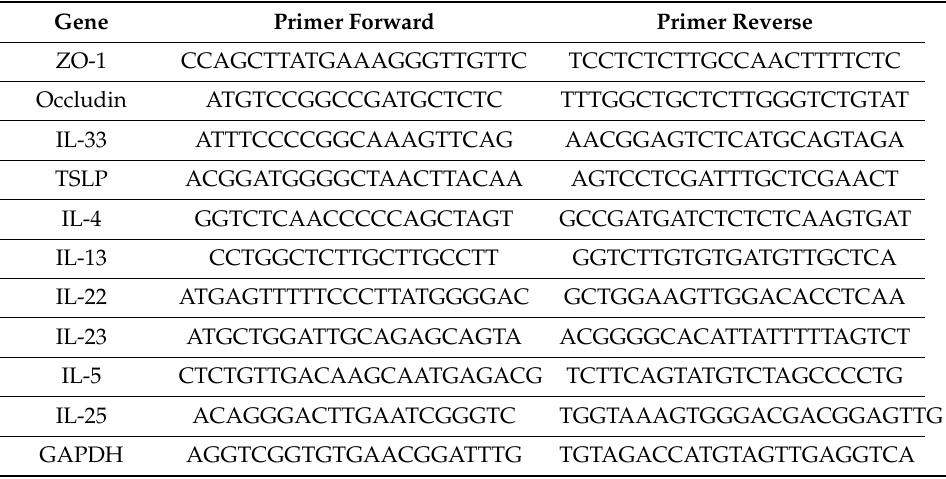
Table 1. Nucleotide sequence of the primers